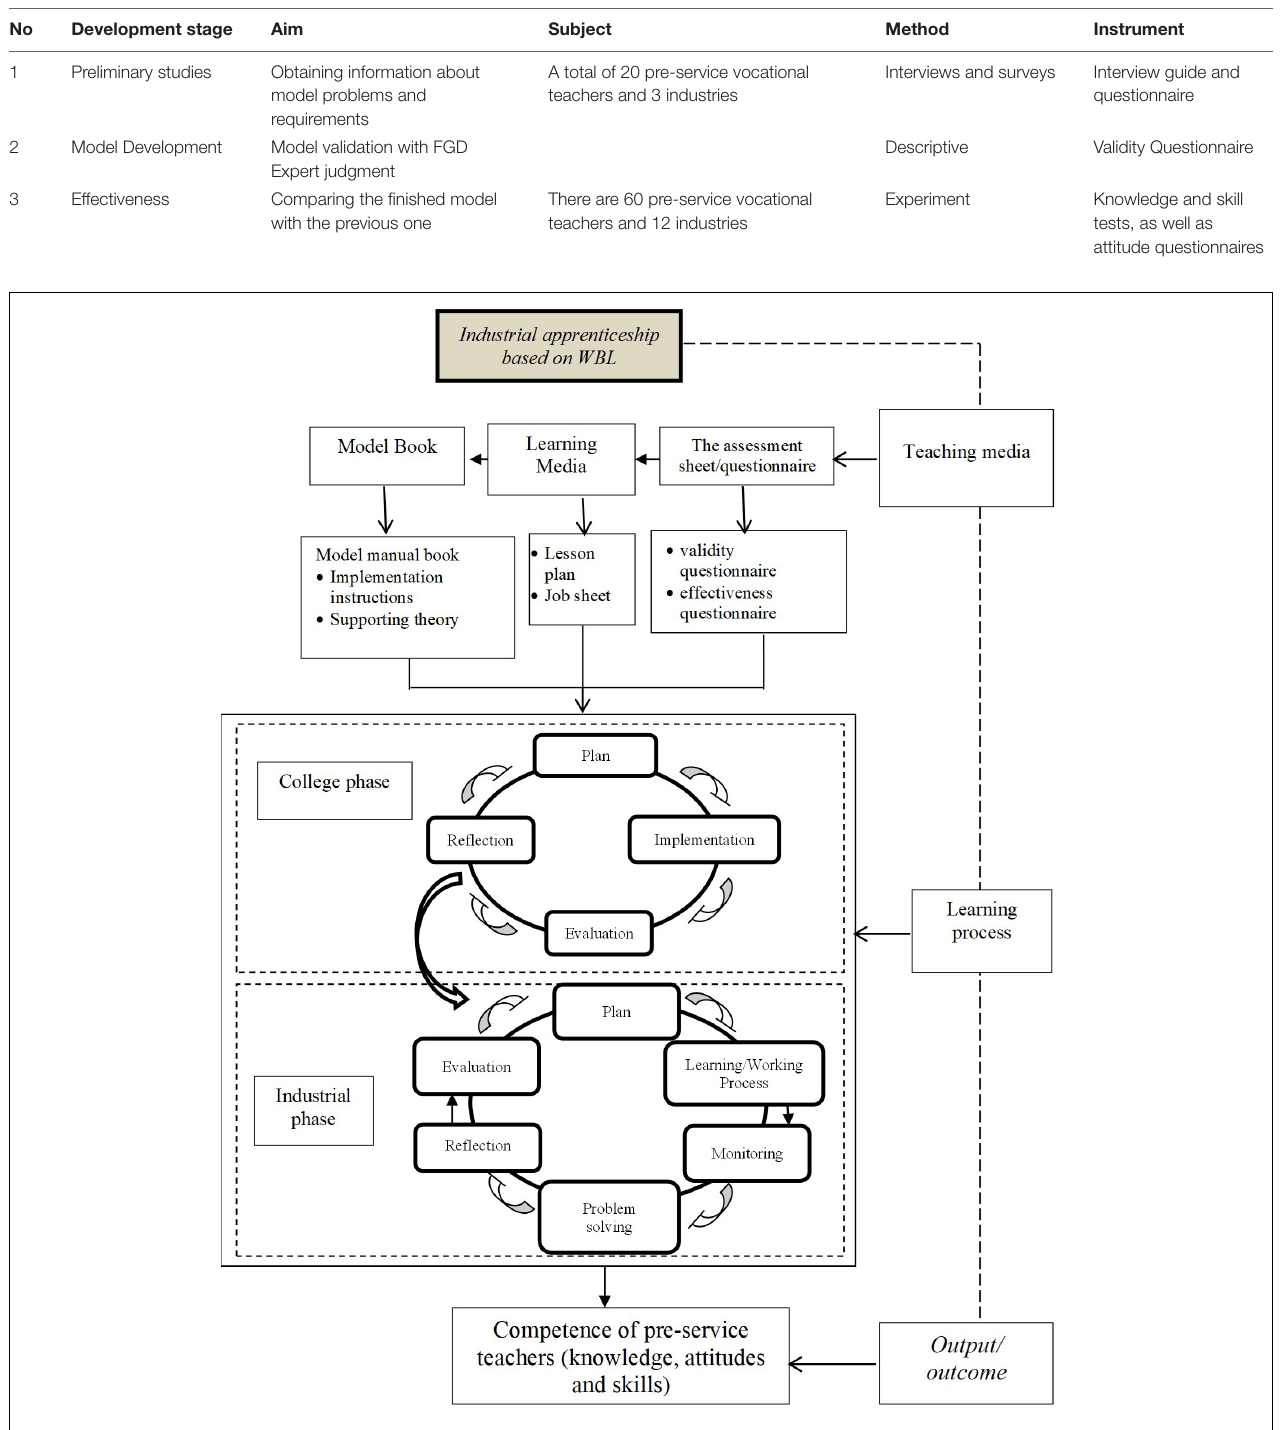
TABLE 2 | Matrix of R and D phase research methods.